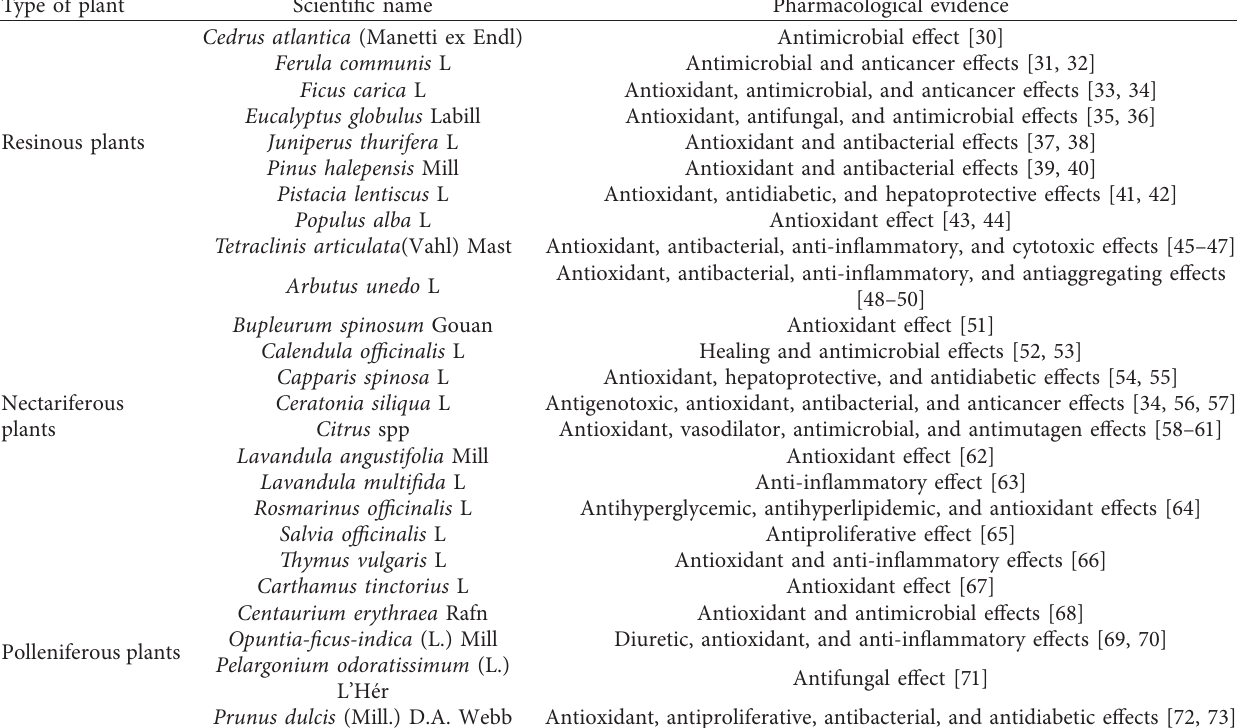
Table 5: Review of the pharmacological evidence of the best melliferous plants existed in the Fez-Meknes region according to the beekeeper’s